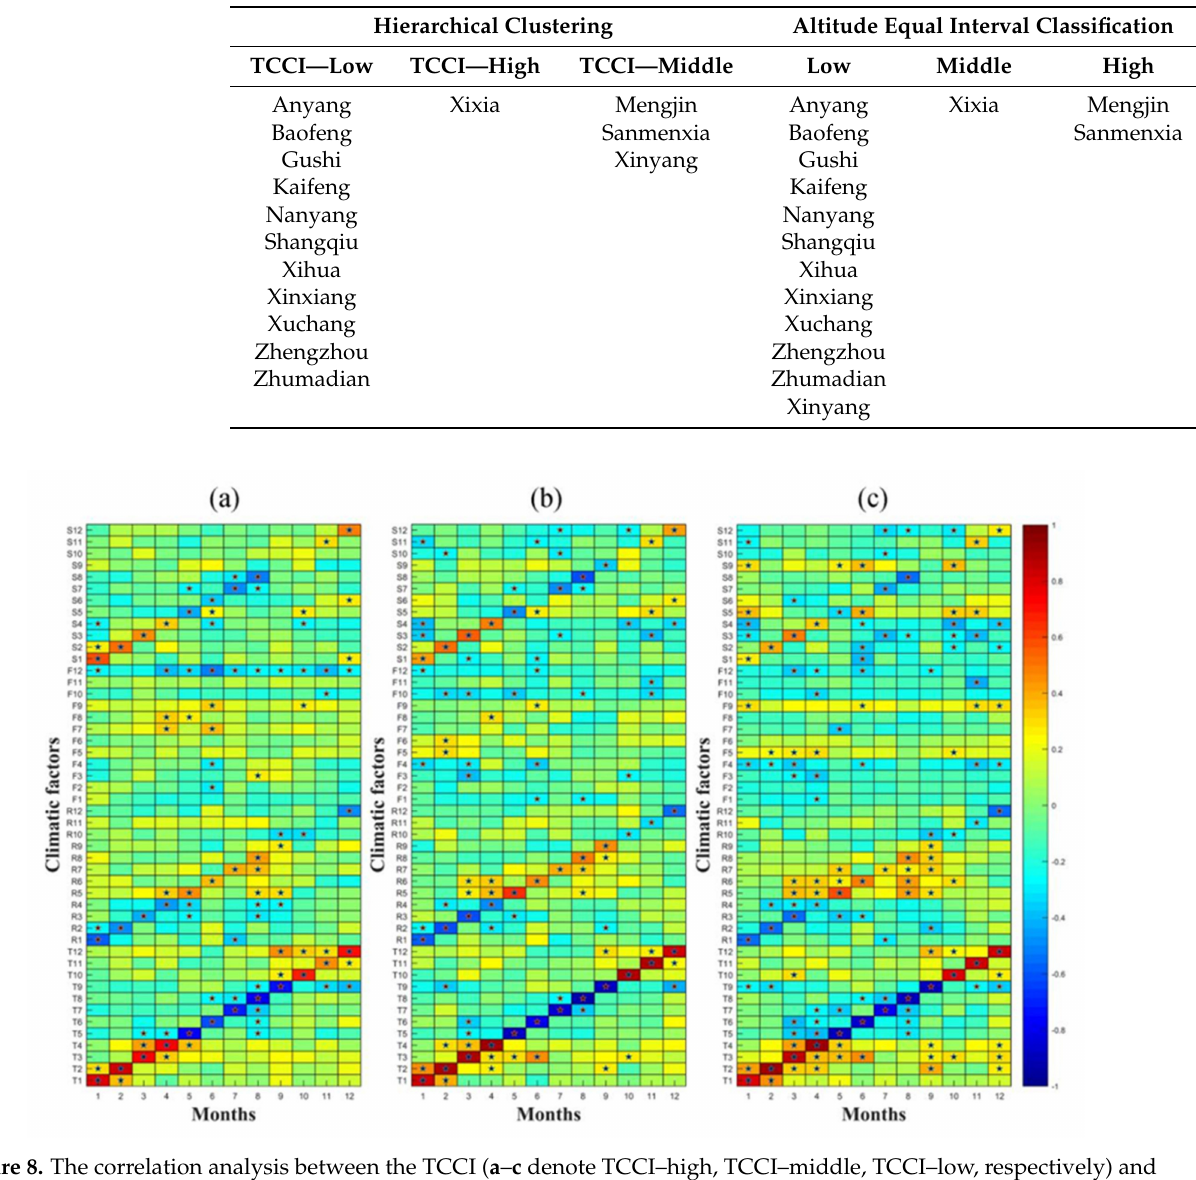
Figure 8. The correlation analysis between the TCCI ( a – c denote TCCI–high, TCCI–middle, TCCI–low, respectively) and climate factors. The pentagram indicates that the correlation results reached a 95% significance level. T, R, F and S represent the mean temperature, mean relative humidity, mean wind speed and mean sunshine duration,